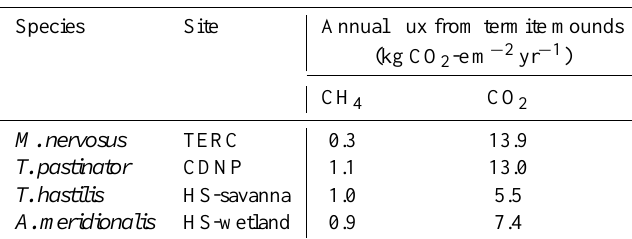
Table 5. Annual CO 2 -e fluxes of CH 4 and CO 2 from termite mounds of the four common species